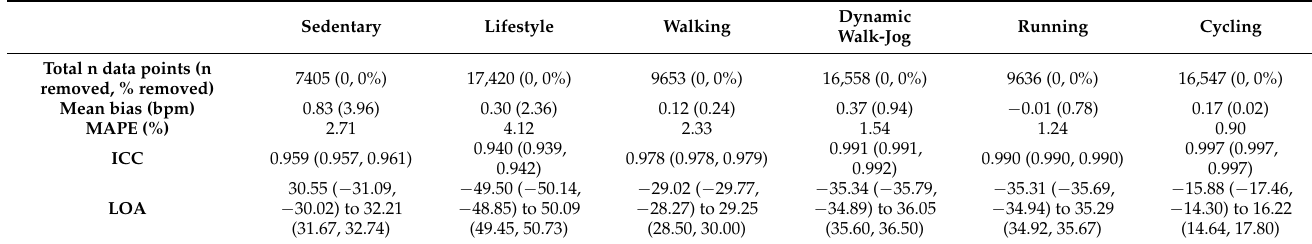
Table 4. Results of all tests for the Scosche Rhythm 24 armband. Sedentary Lifestyle Walking Dynamic Walk-Jog Running